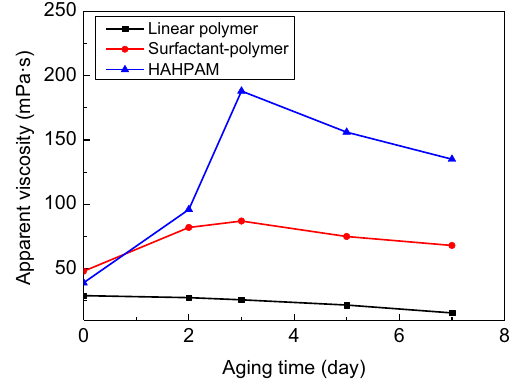
Fig. 5 Long-term thermal stability of 0.2 wt% linear polymer, 0.2 wt% surfactant–polymer, and 0.2% HAHPAM polymer (salin- ity = 9000 mg L, [Ca 2+ ] + [Mg 2+ ] = 900 mg L −1 , ̇𝛾 = 7.34 s −1 ).